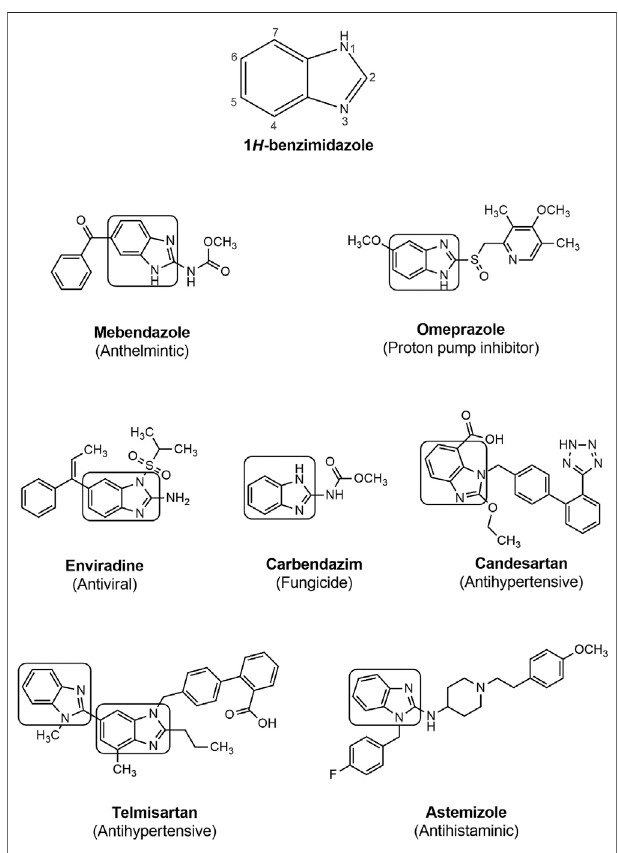
FIGURE 2 | 1 H -benzimidazole and some benzimidazole containing